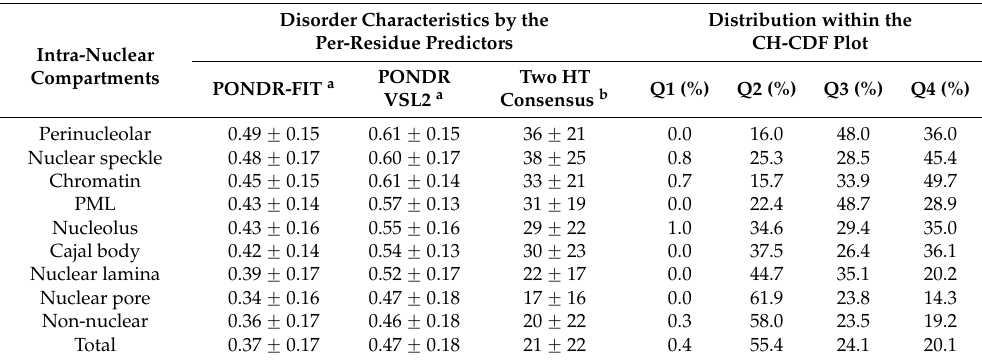
Distribution within the CH-CDF Plot